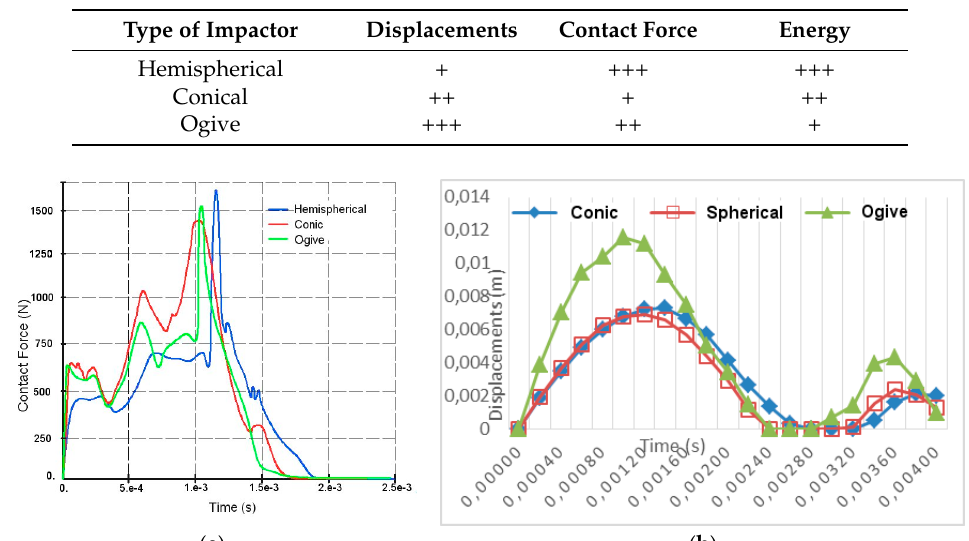
Table 2. Comparative effects impactors, displacement contact force and energy produced. “+”, ”++”, and “+++” used for low, moderate, and high values, respectively.